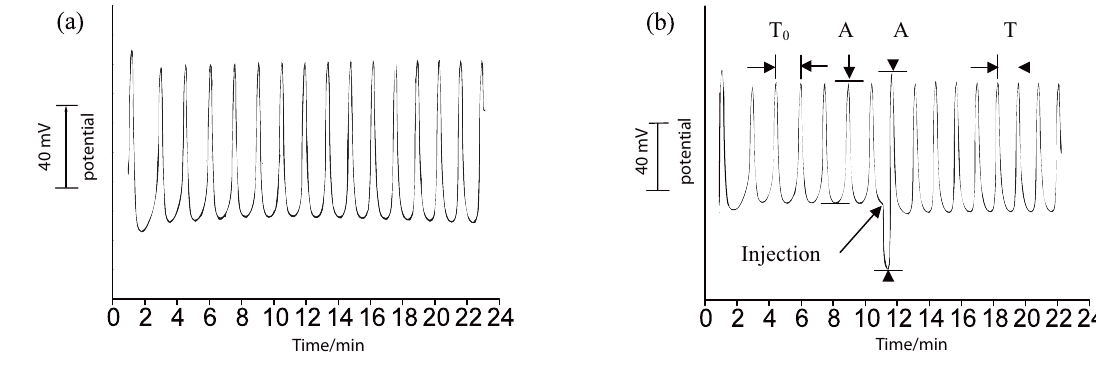
Figure 1. Typical oscillation profiles for the proposed oscillation system in the absence and presence of 5 × 10 -6 M Alizarin Red S perturbation using platinum electrode. Horizontal lines mark the top and bottom of the perturbed amplitude measurement: (a) [Alizarin Red S] = 0.000 M; (b) [Alizarin Red S] = 5 × 10 -6 M. Common conditions: [NaBrO